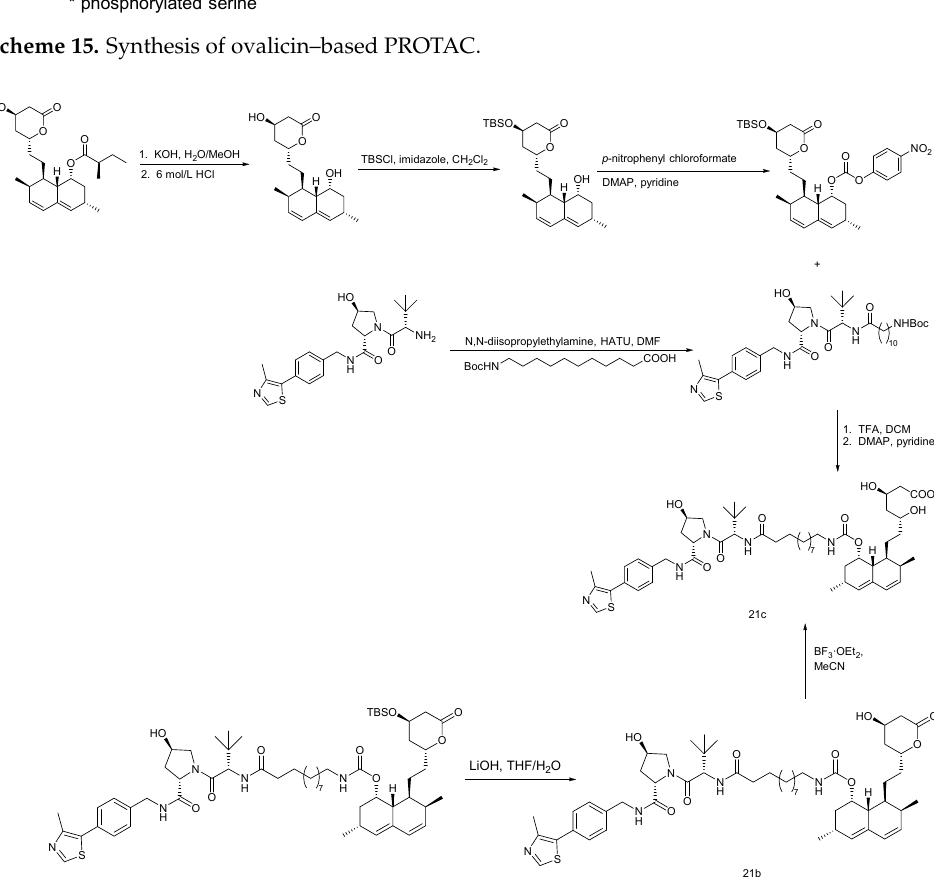
Scheme 16. Synthesis of lovastatin–based